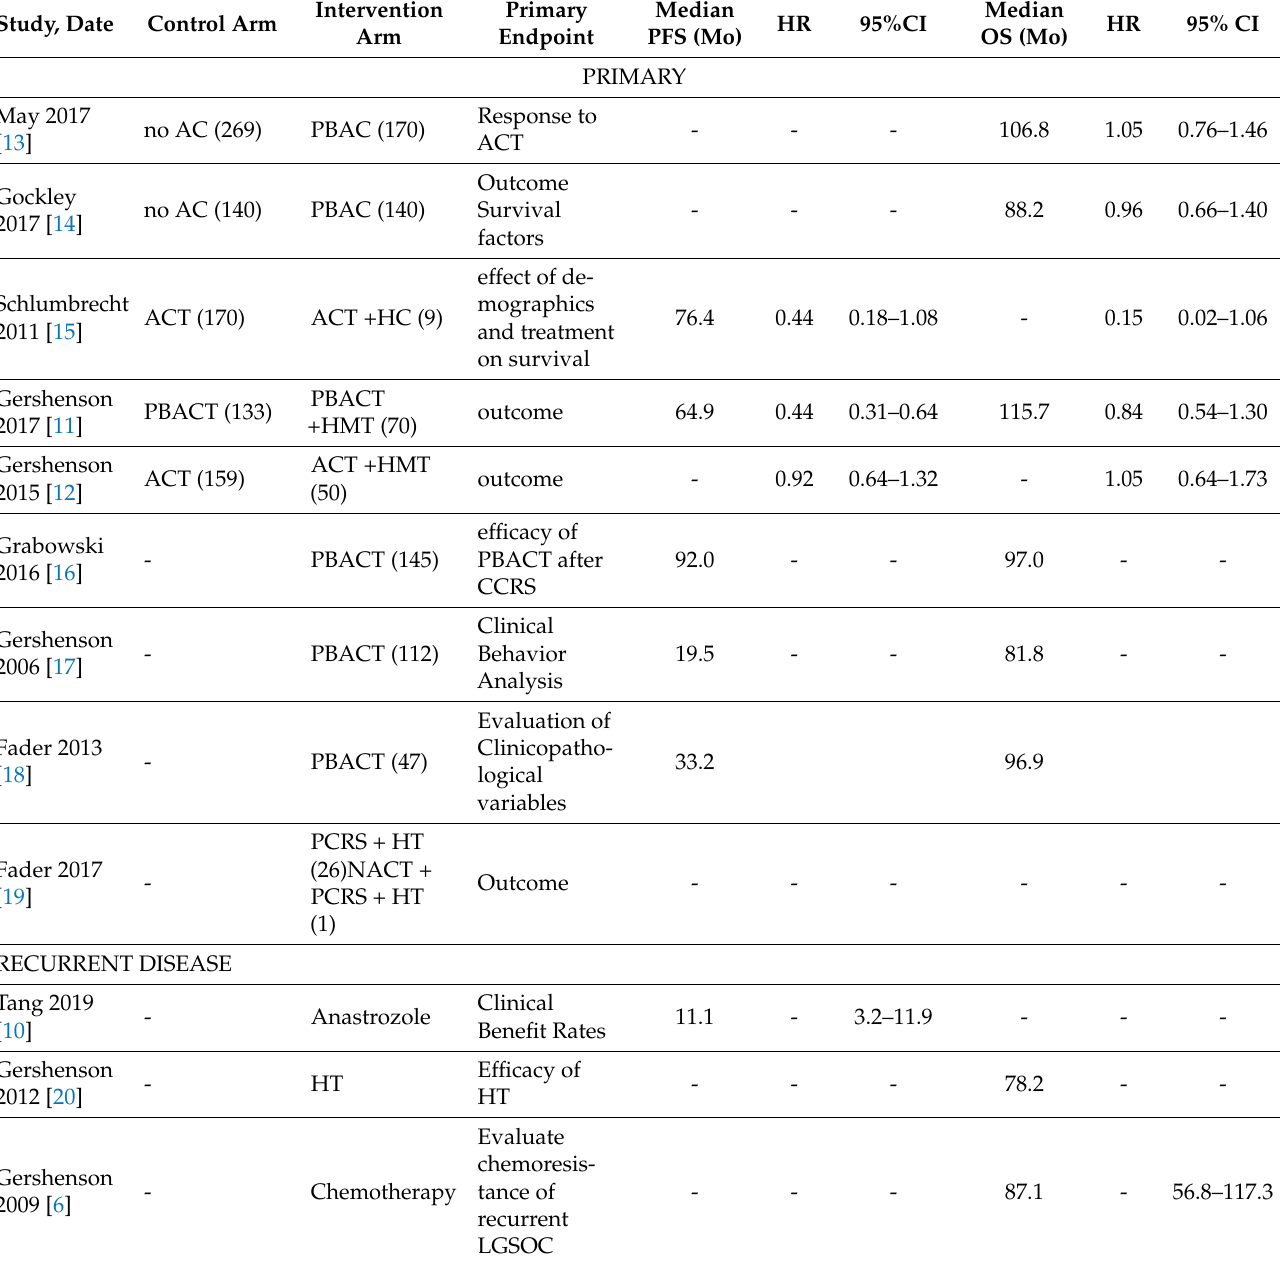
Table 3. Summary of the qualitative characteristics of the 12 included studies for primary and recurrence